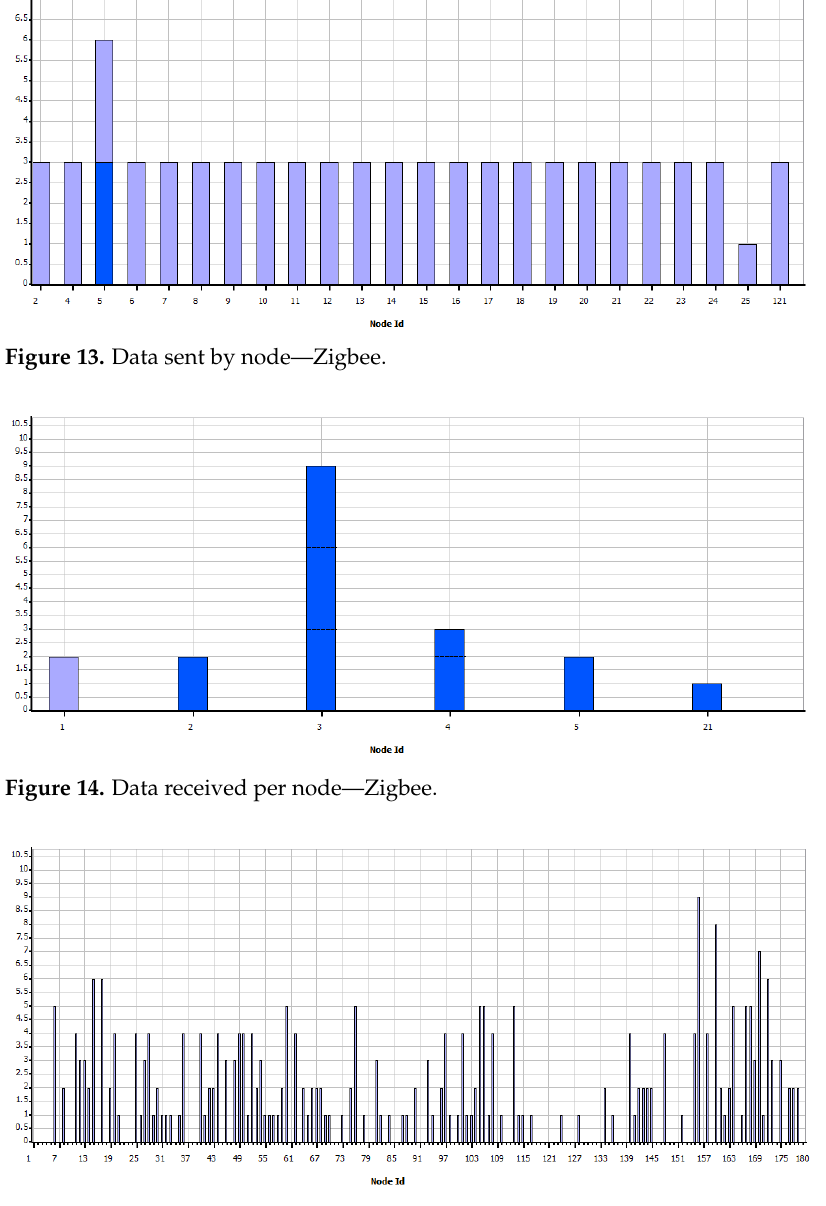
Figure 15. Broken links at each